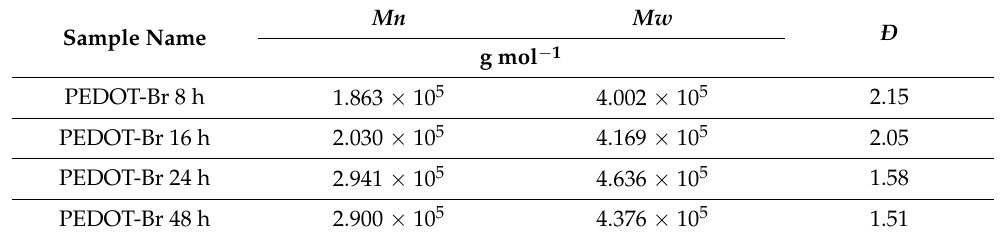
Table 2. Gel permeation chromatography (GPC) results.